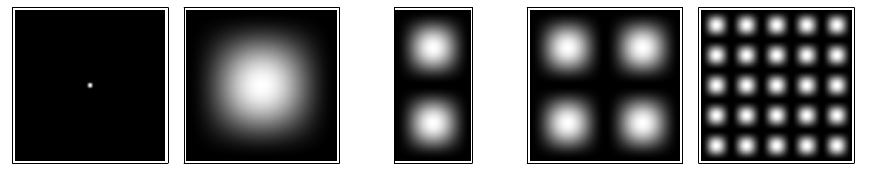
Figure 9. Multiscale integration in scale relativity. Elementary objects—at a given level of description (left figure)—are organized in terms of a finite structure described by a probability density distribution (second figure from the left). By increasing the energy, this structure spontaneously duplicates (third figure). New increases of energy lead to new duplications (fourth figure), then to a “tissue”-like organization (fifth figure—the scale of the figures is not conserved).